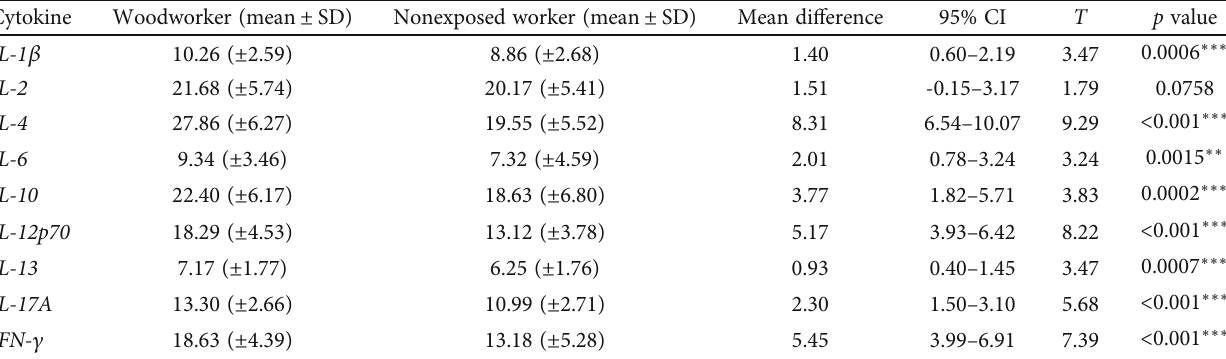
Table 2: Result of compared cytokine levels between woodworkers and nonexposed workers. Cytokine Woodworker ( mean ± SD )